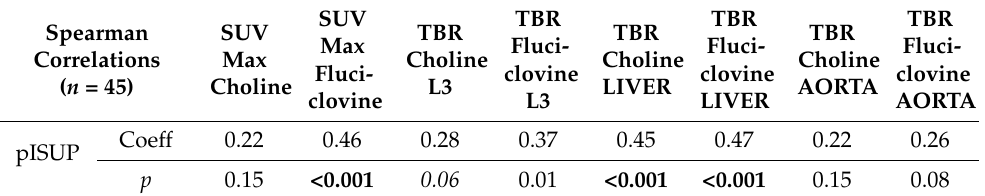
Table 2. Linear correlation test between [ 18 F]Fluciclovine and [ 11 C]Choline and pISUP of malignant lesions ( n = 45).